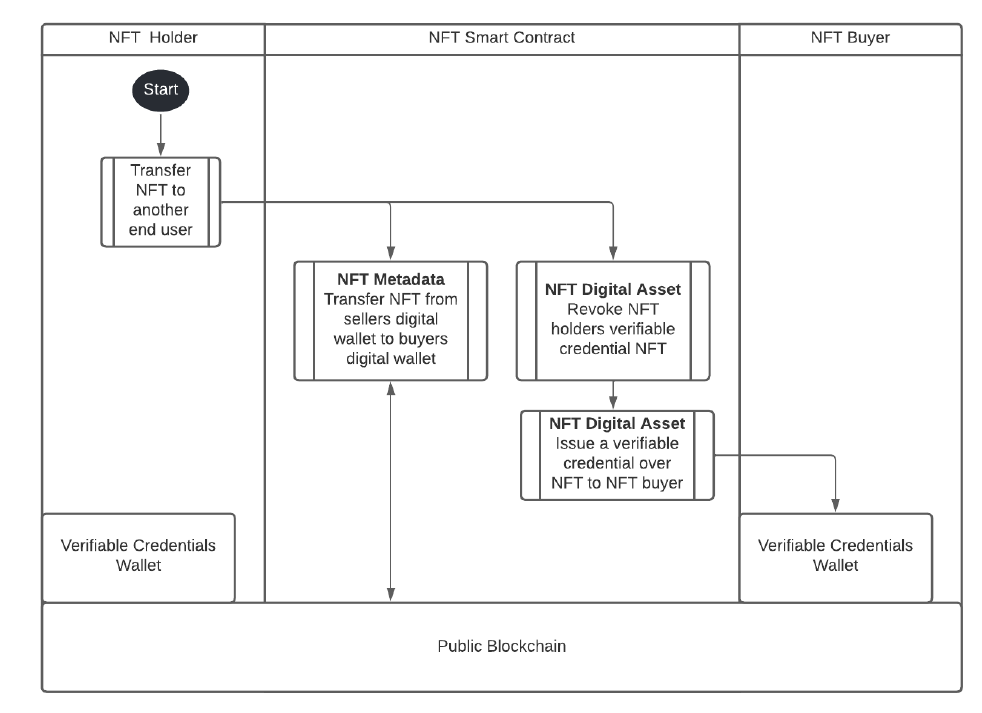
Figure 9. NFT transfer